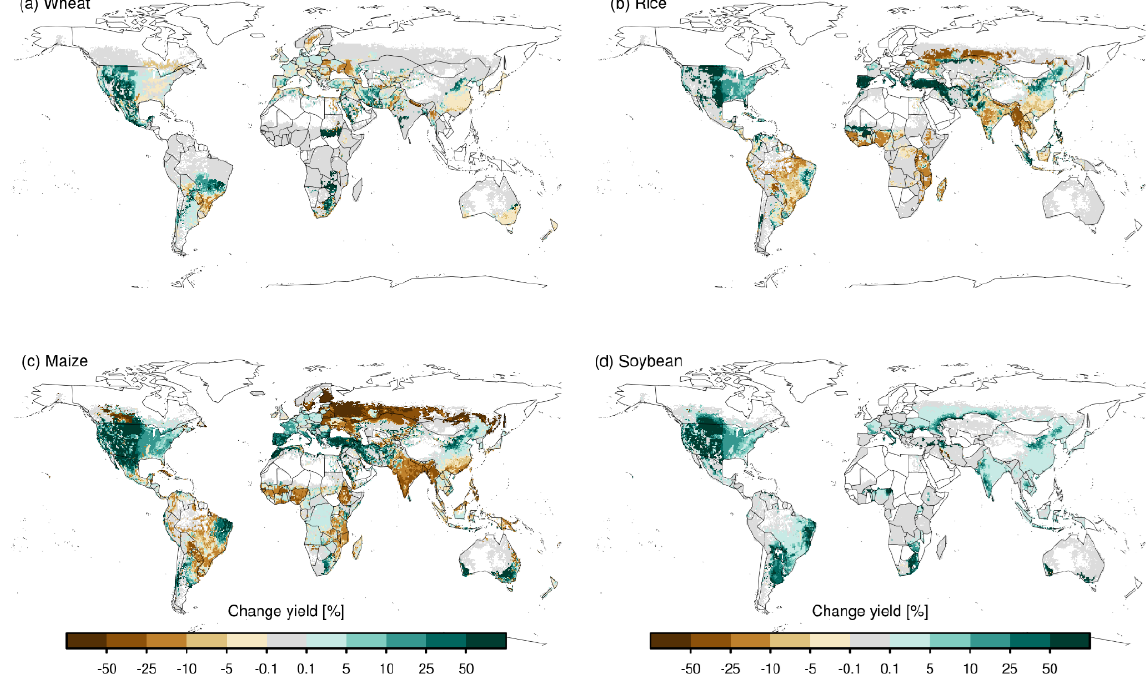
Figure 6. Maps (a) – (d) showing changes in main-crop average productivity in response to cover crop practices combined with no-tillage (CCNT) compared to the baseline scenario with conventional tillage and bare fallow on cropland during main-crop off-season periods (REF) as annual area-weighted median relative differences in percent (%) of crop-specific cropland and grid cell (pattern of the year 2010, Sect. 2.3) for wheat, rice, maize, and soybean for the 50-year simulation